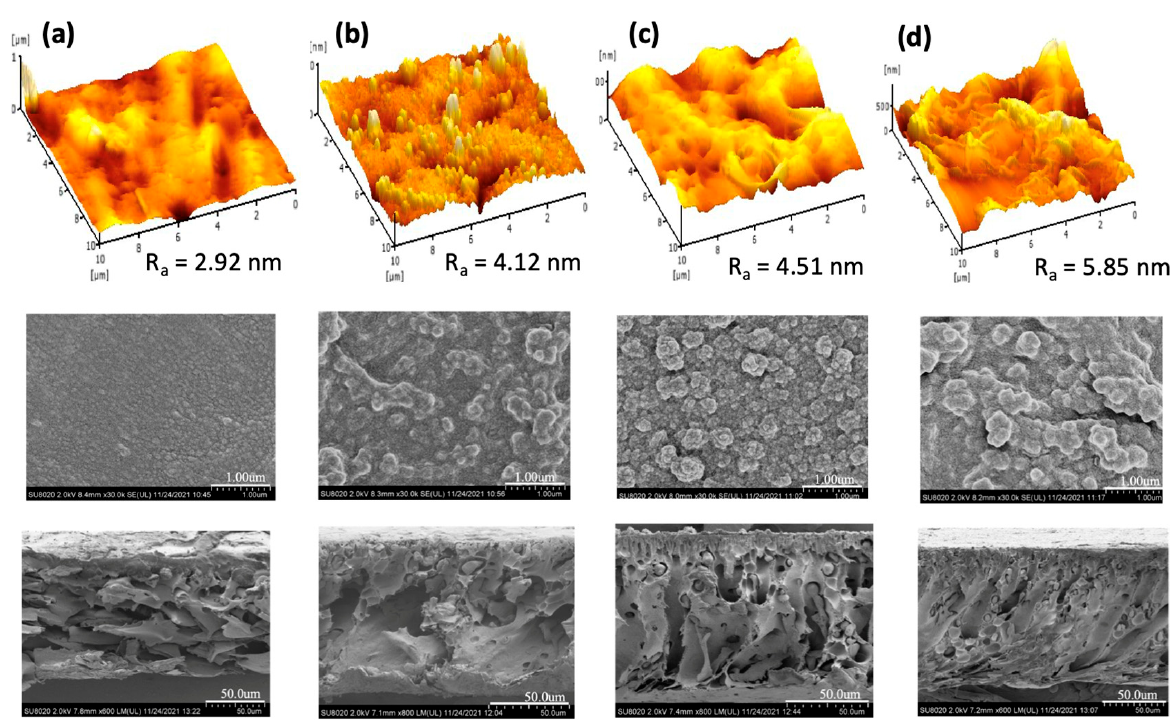
Figure 3. Three-dimensional AFM images ( top ), FESEM surface images ( middle ), and FESEM cross- sectional substrate images of TFC membrane made of different substrates: ( a ) 1:1 PAN/PPSU, ( b ) 1:3 PAN/PPSU, ( c ) 1:5 PAN/PPSU, and ( d ) 1:7 PAN/PPSU.